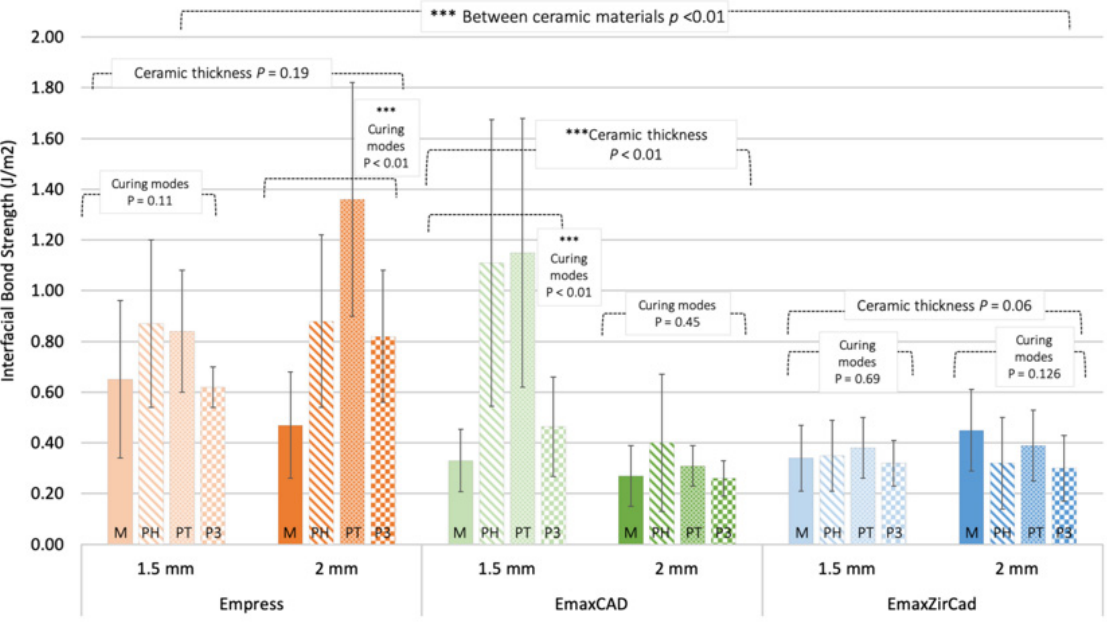
Figure 4. Bar chart plotting the mean and standard deviation of interfacial bond strength. (Empress–